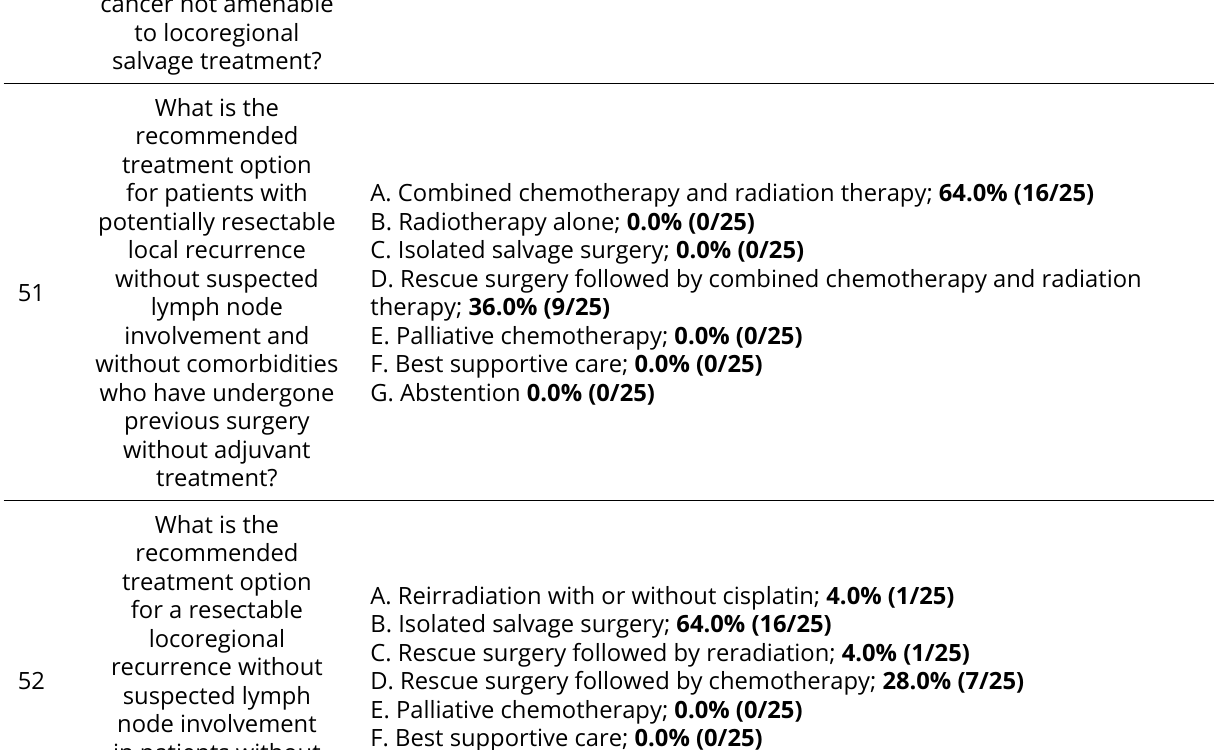
Key issues in the management of cervical cancer: consensus recommendations by a Brazilian expert panel Brazilian Journal of Oncology